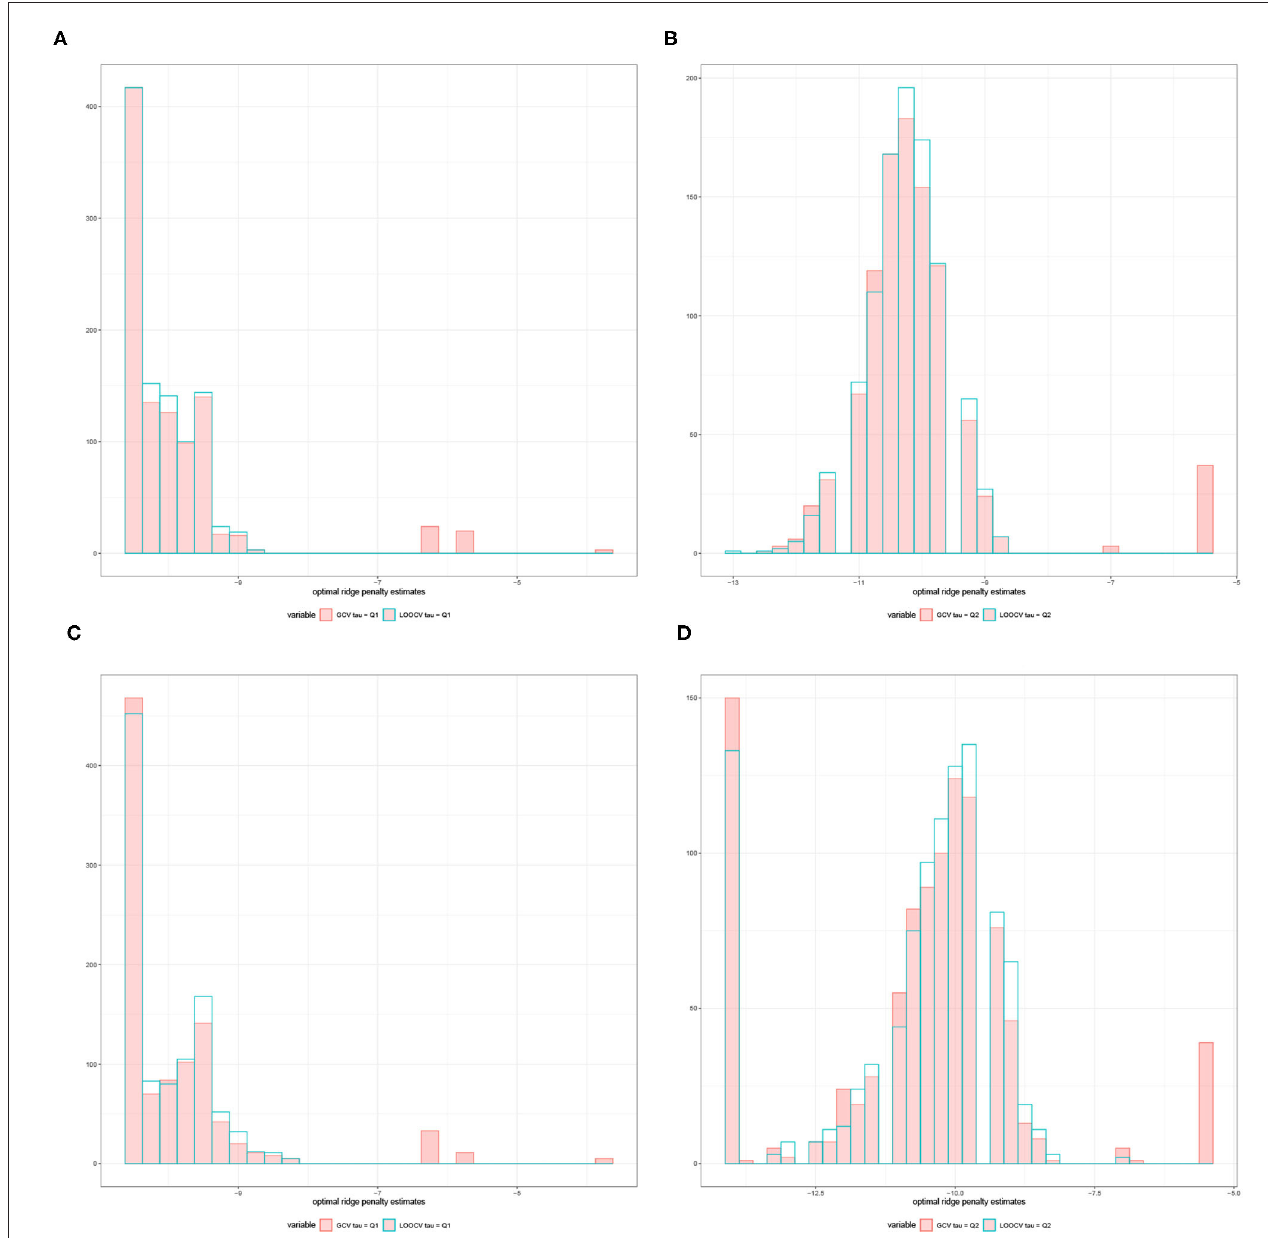
FIGURE 3 | Histograms comparing the optimal ridge penalty parameter in a replication with 1,000 permutations using GCV vs. LOOCV when the threshold τ is the (A) first quartile and (B) median. The simulated design matrix X for (A,B) has a compound symmetric covariance structure with n = 350 and p = 1,000, β = 0 and error standard deviation σ = 1. The simulated design matrix X for (C,D) has a compound symmetric covariance structure with n = 350 and p = 1,000. The response is generated using fixed effects β = ξ 1 p , ξ = 3 and error standard deviation σ = 1.